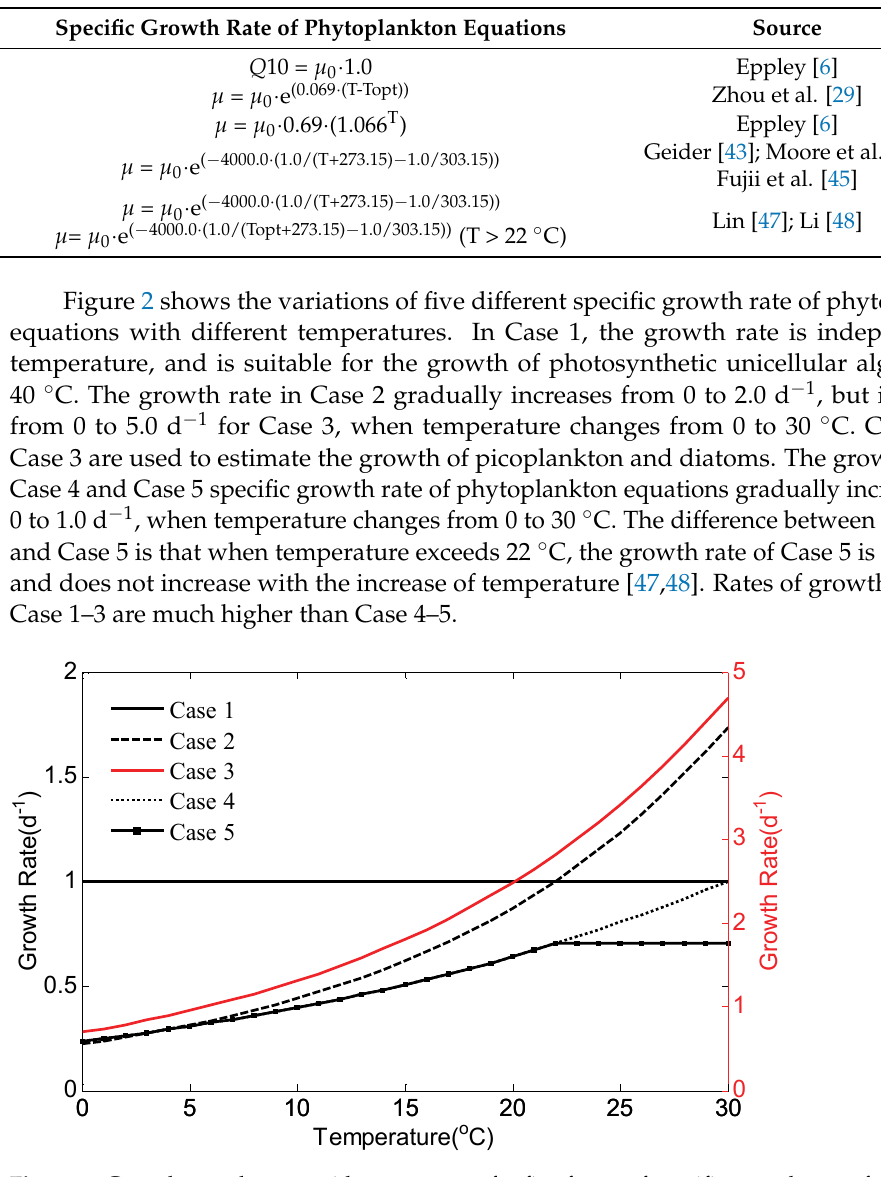
Figure 2. Growth rate changes with temperature for five forms of specific growth rate of phytoplankton equation, Case 1 to 5.